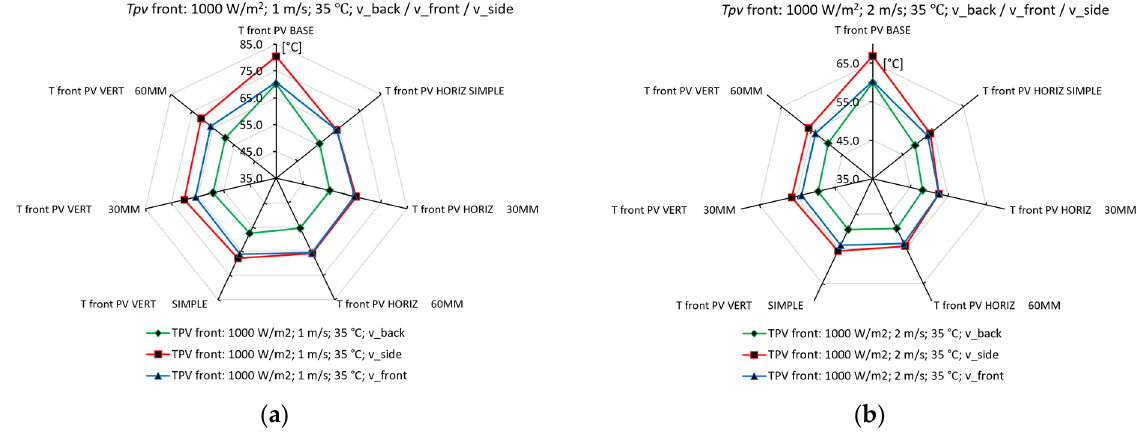
Figure 8. Variation of average operating temperature for ( a ) v air = 1 m/s; ( b ) v air = 2 m/s.